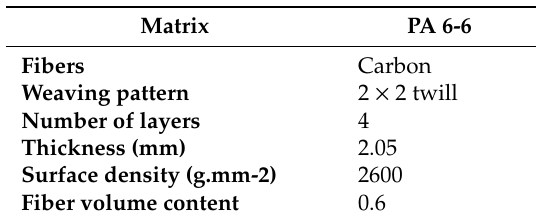
Table 1. Main material properties.